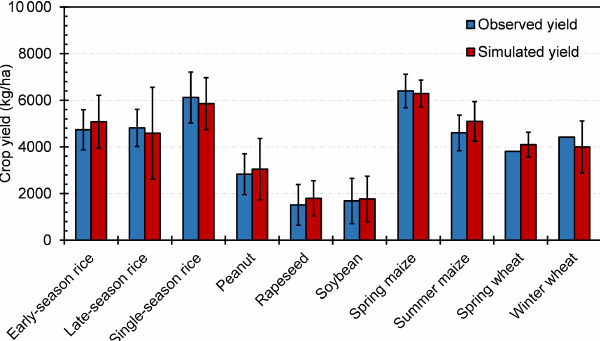
Figure 2. Comparison between the simulated and observed crop mean yields of different crops on the Yangtze Plain; the mean values were averaged over the period 2000–2015 and across 179 total sites. Error bars show 1 standard deviation of crop